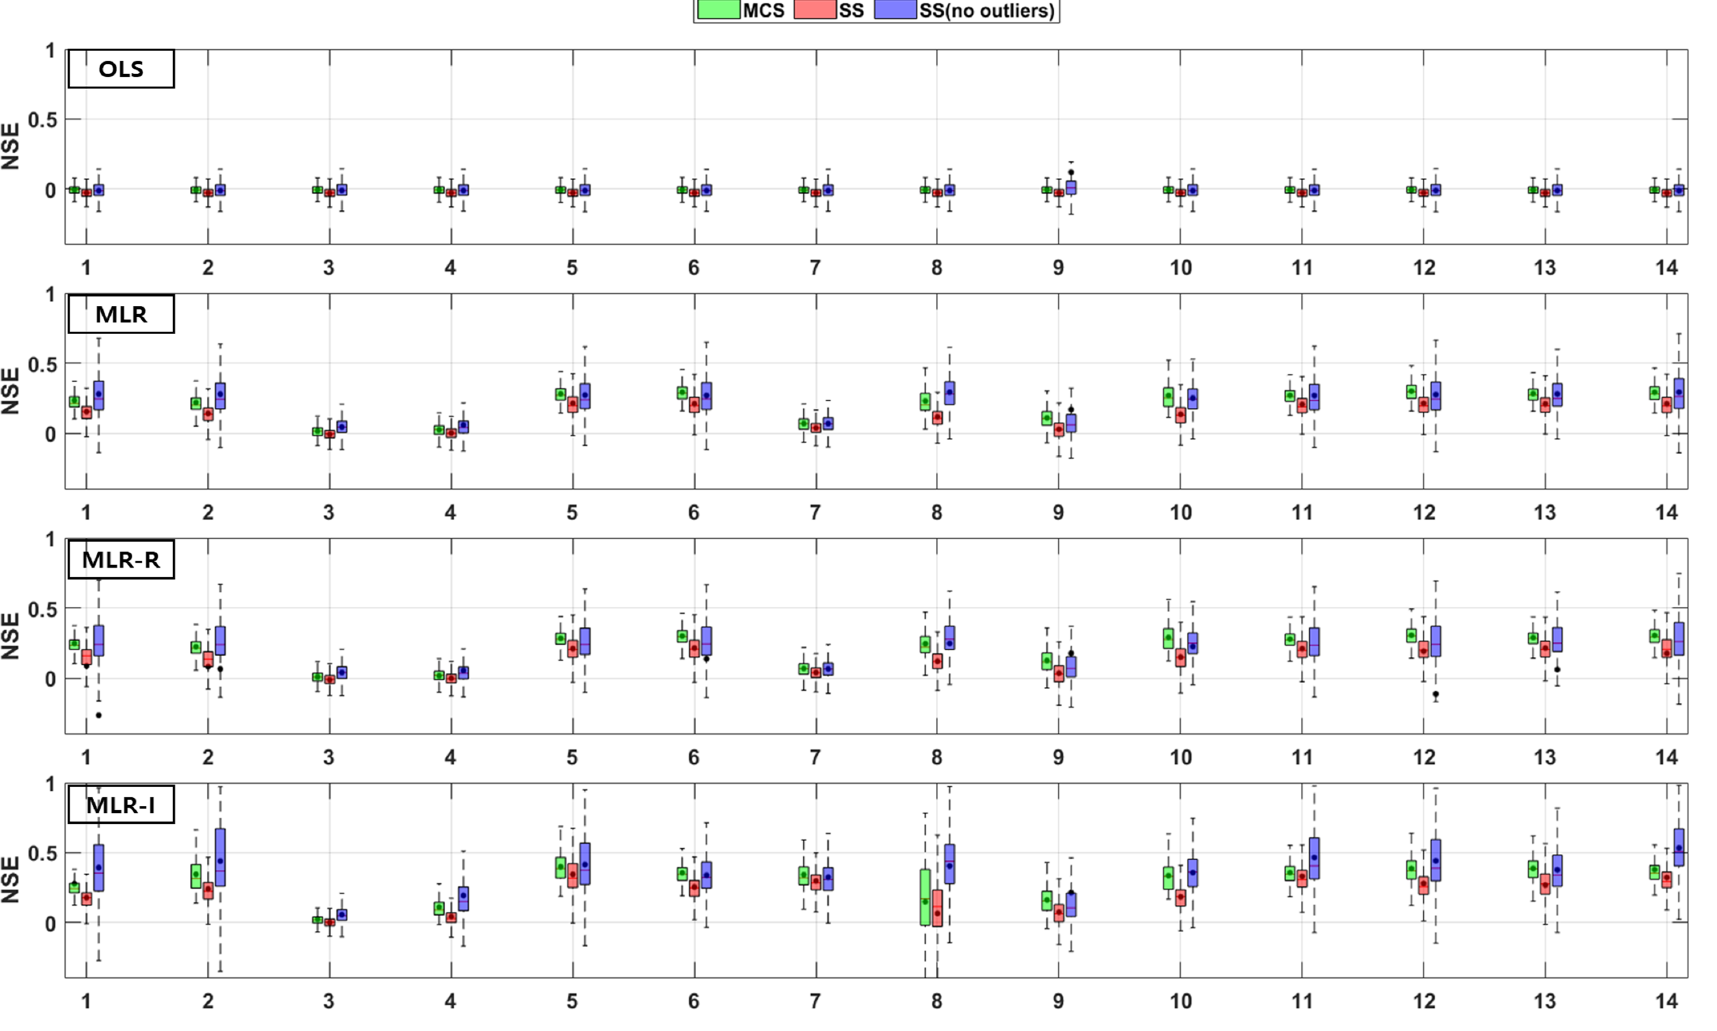
Figure 12. Error analysis (NSE) results of TSS removal in retention ponds.